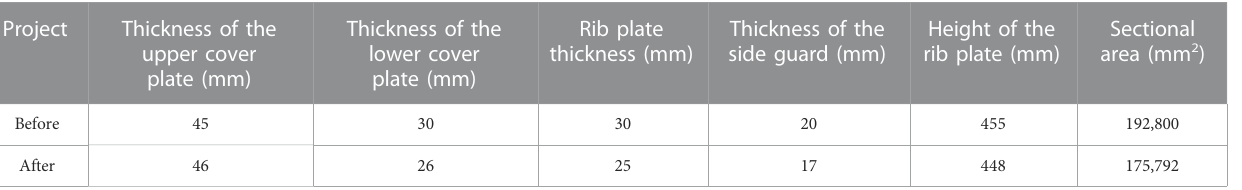
TABLE 1 Parameters of the roof beam before and after optimization.